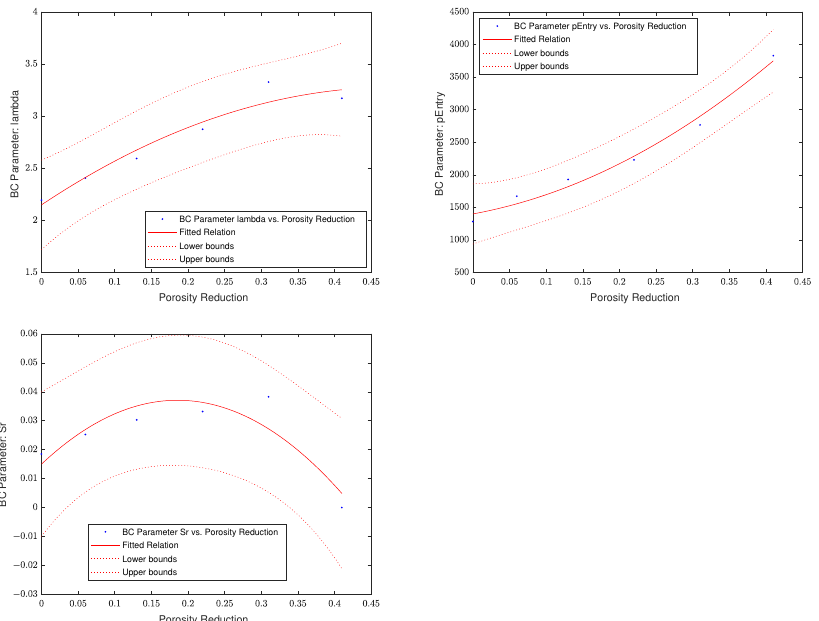
Figure 8. Observed dependency of the Brooks–Corey parameters on the porosity reduction λ ( left ), entry pressure p e ( right ), and residual saturation S r ( bottom ) for Experiment 2D1.